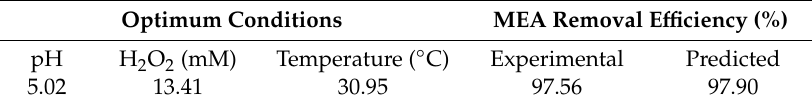
Table 4. The removal efficiency of MEA under the optimal conditions.